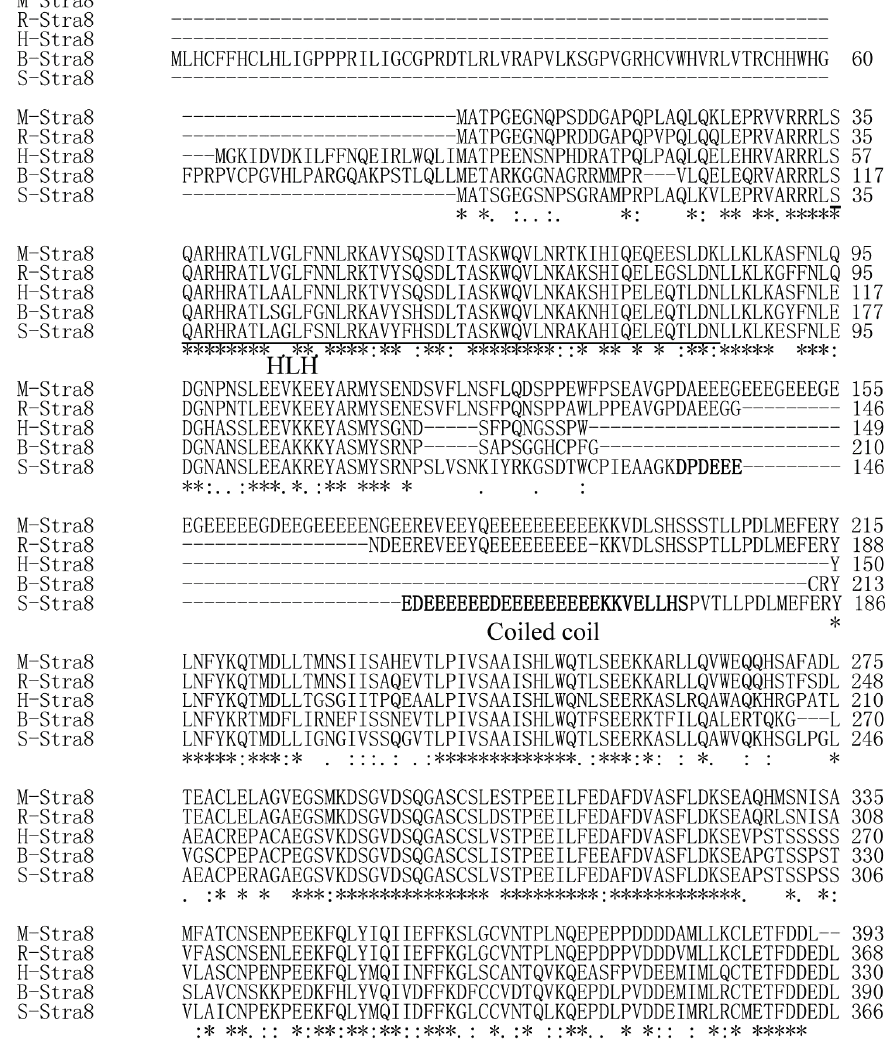
Figure 3. Amino acid sequence alignment of STRA8. M-STRA8: mouse STRA8; R-STRA8: rat STRA8; H-STRA8: human STRA8; B-Stra8: bovine STRA8; S-STRA8: pig Stra8. HLH: helix-loop-helix. “*” the amino acid is identical in this position; “:” the amino acid in this position is conserved; “.” the amino acid in this position is semi-conserved. Pig HLH structure is underlined and Coiled coil is